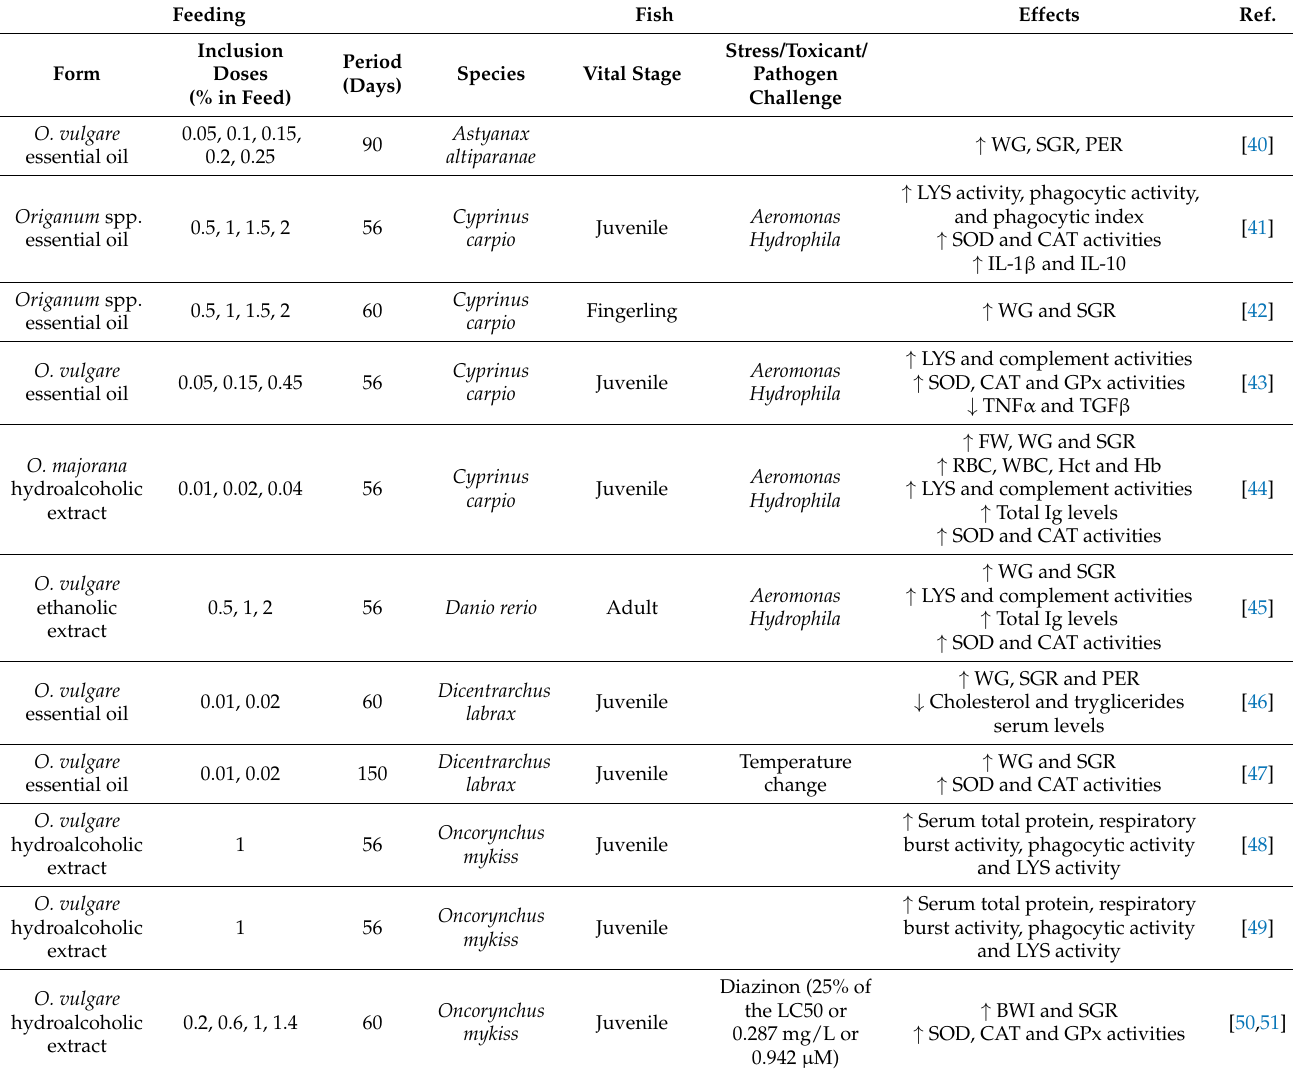
Table 1. Studies of oregano products added to the feed of aquaculture